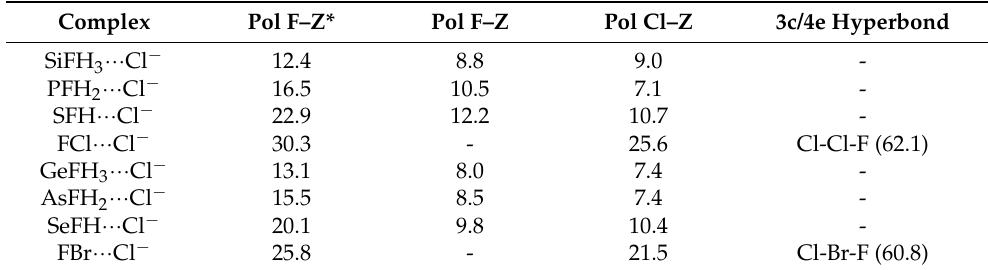
Table 3. Polarizations of the F–Z and Cl–Z bonds; F–Z* is the polarization in the isolated Lewis acid unit. Polarizations express the percentage of the bond orbital electron charge density at the Z-centre. The 3c/4e hyperbonds in halogen-bonded systems are presented; the percentages of the configurations with the Cl–Cl bond and the Cl–Br bonds are given in parentheses. Complex Pol F–Z* Pol F–Z